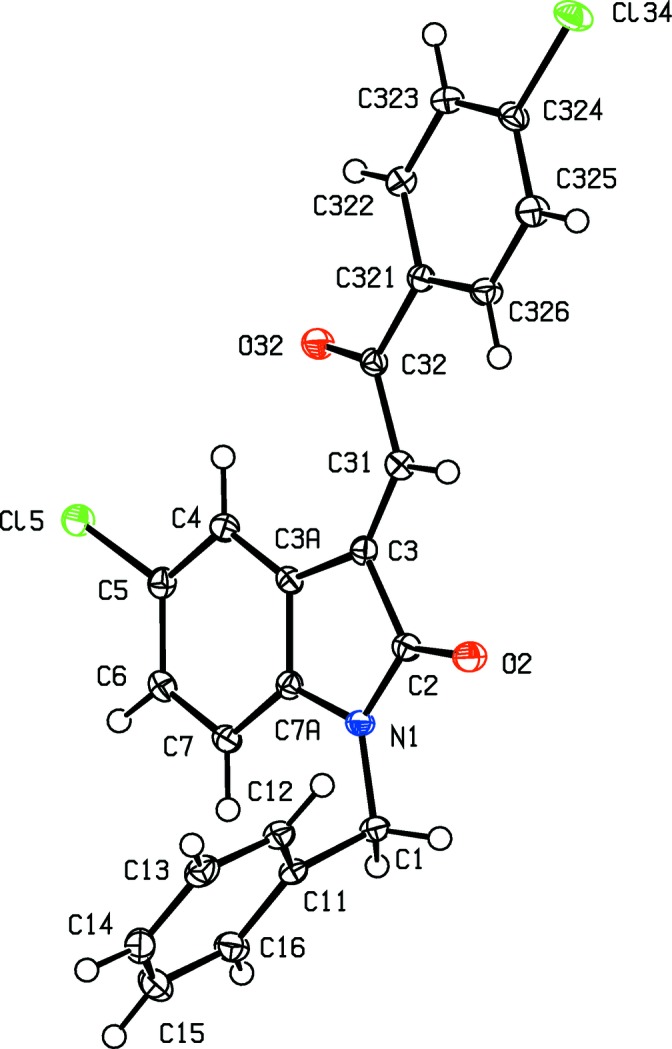
The mol­ecular structure of com­pound (IIh), showing the atom-labelling scheme. Displacement ellipsoids are drawn at the 30% probability level.